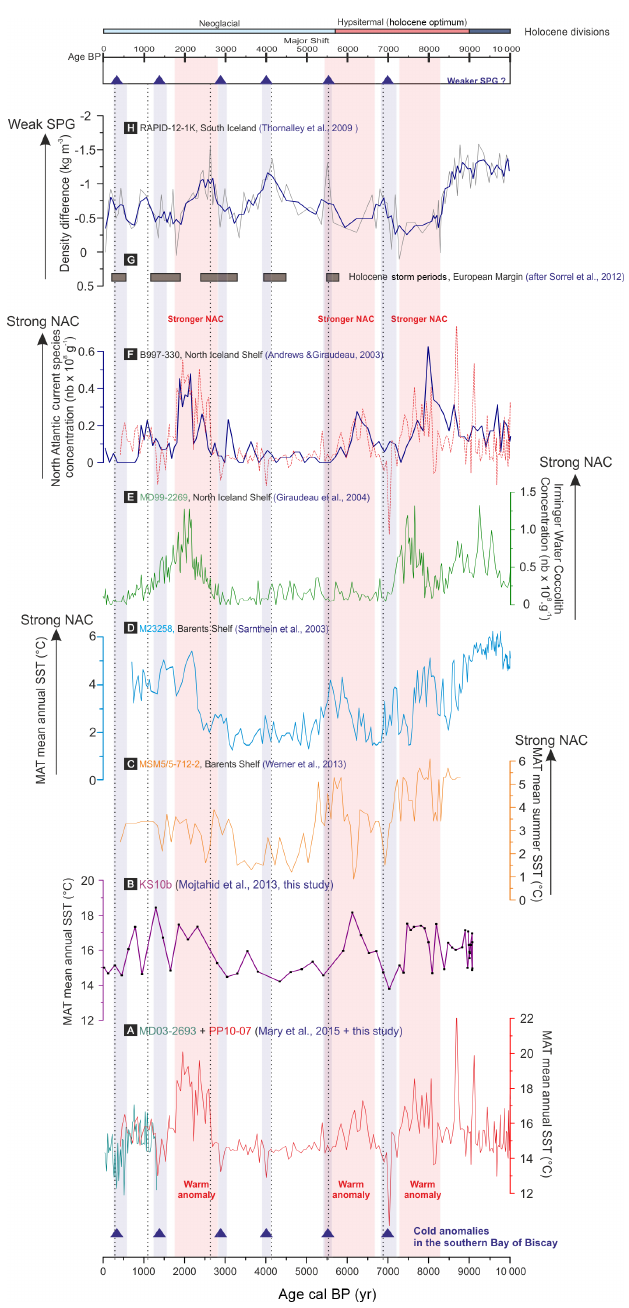
Figure 4. Comparison of annual SST Holocene signals from the Bay of Biscay (a, b) with records from the northern North Atlantic highlighting variations of the NAC intensity and SPG dynamics; (c) SST signal of core MSM5/5-712-2 (Fram Strait; Werner et al., 2013) and of (d) core M23258 (Barents Shelf, after Sarnthein et al., 2003), both reconstructed using the modern analogue technique (MAT) based on planktonic foraminifera; (e) concentration of NAC indicator coccolith species in core MD99-2269 (North Iceland Shelf, after Giraudeau et al., 2004) and in (f) core B997-330 (North Iceland Shelf, after Andrews and Giraudeau, 2003; the PP10-07 record here is also plotted by a thin dotted red line to underline the comparison); (g) Holocene storm periods (after Sorrel et al., 2012) reconstructed from sedimentological evidence from a compilation of coastal cores in northwestern Europe; and (h) core Rapid-12-1K (Thornalley et al., 2009) proxy for upper-water-column stratification, calculated using derived Mg / Ca and δ 18 O temperatures and salinities of G. bulloides and G. inflata . Dotted vertical lines point out events of density difference between the near-surface and base of the seasonal thermocline in the southern Iceland Basin. The topmost dark blue triangles and light blue vertical bands point to cold anomalies recorded in the southern Bay of Biscay (potentially corresponding to a weak SPG). Pink bands conversely highlight periods of warmth which also correspond to enhanced NAC activity north of Iceland. Changes in gyre circulation dynamics are compared with the Holocene division of Wanner et al.